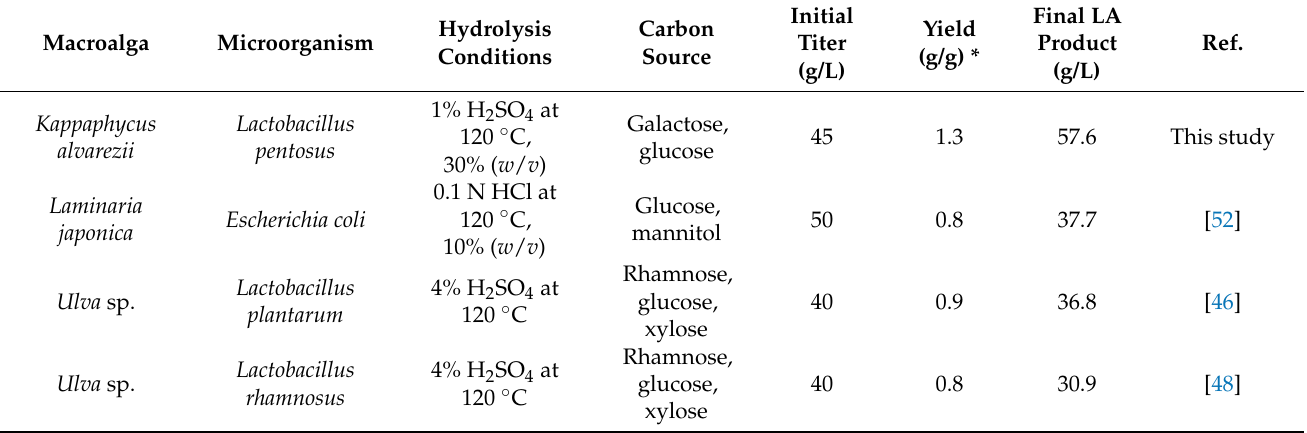
Table 8. Serum flask scale production of lactic acid from seaweed hydrolysates reported in